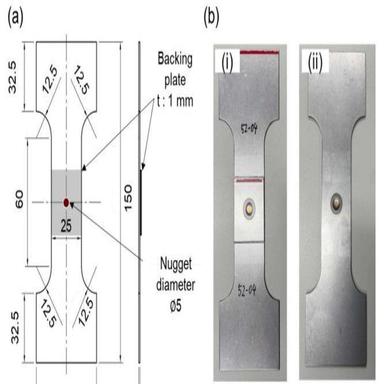
Dumbbell-type tensile test specimen. (a) Dimension of spot-welded uniaxial tensile specimen, (b) photos of dumbbell specimen and backing plate.